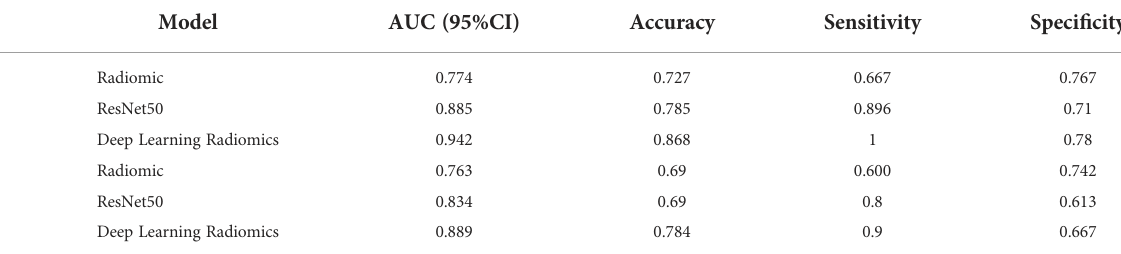
TABLE 2 Performance of training and testing sets in three